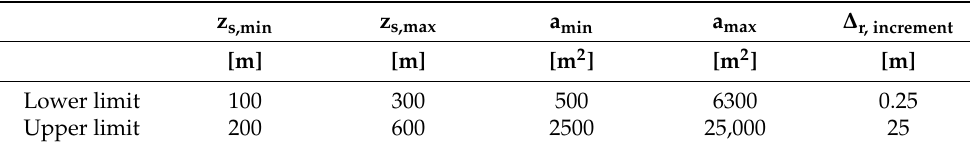
Table 3. Decision variables constraints used in the optimization process of the slip-surfaces search parameters for SCOOPS